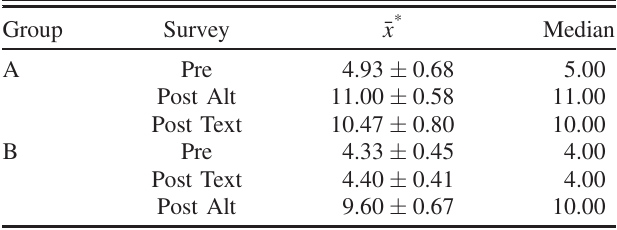
TABLE I. Descriptive statistics on overall survey scores for groups A and B ( n ¼ 15 for each group).